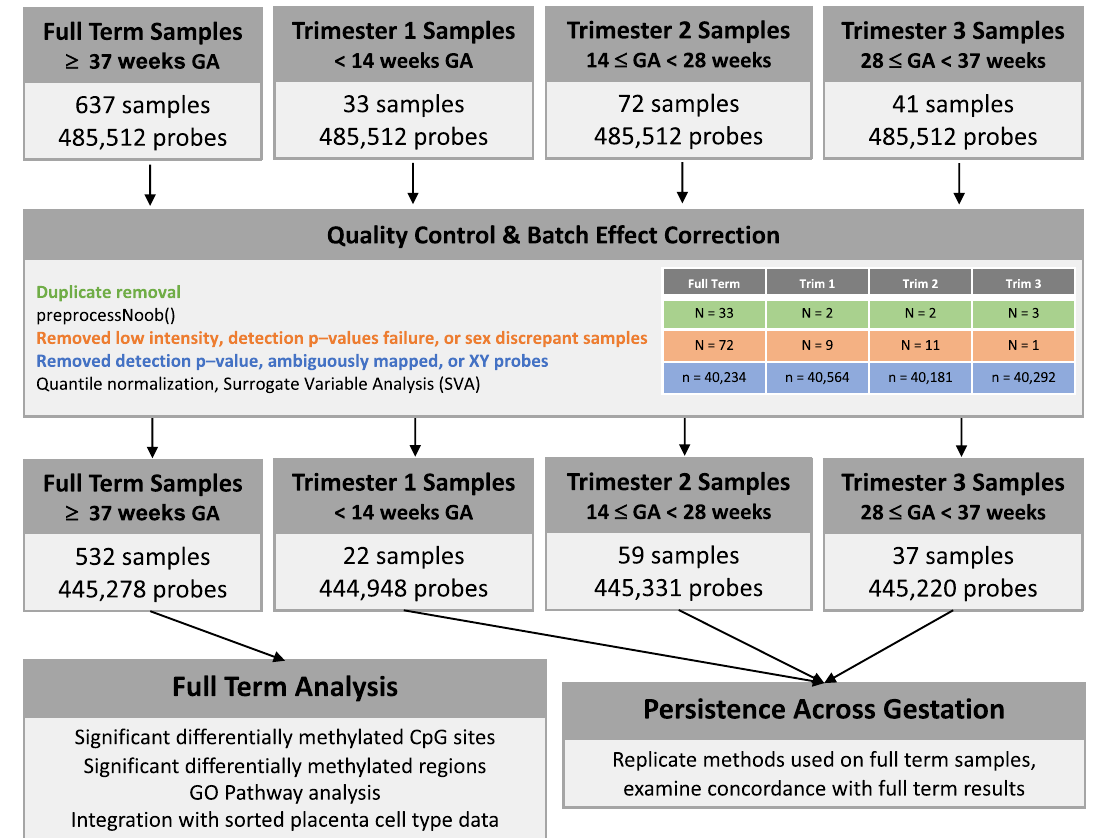
Figure 1. Study design and methodology. Illumina 450K datasets of fetal placenta samples were downloaded from GEO and restricted to those from normal/typical pregnancies to the fullest extent possible (see “Methods”). Samples were classified into 4 groups according to annotated gestational age, and each dataset was processed through identical subject and probe level QC steps. Single site and region-based analyses were performed in full term samples first, and then also performed in individual trimester datasets to examine replication of full term findings. See “Methods” for additional